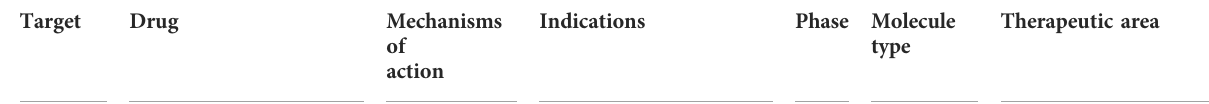
TABLE 1 Suggested repurposable drugs retrieved from Open Targets